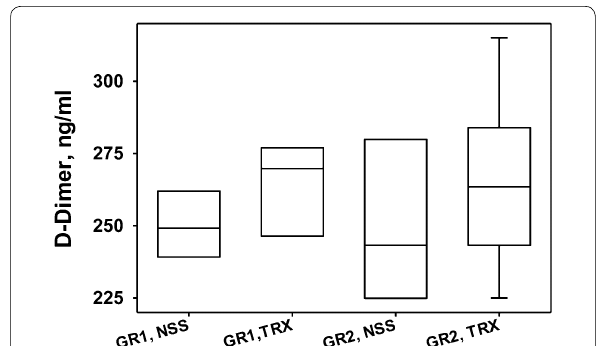
Fig. 8 The effect of fibrinolytic therapy on concentrations of d -dimers in BAL of Groups 1 and 2. The concentration of d -dimer in BAL of ISIALI sheep after fibrinolytic therapy was measured using a sheep d -dimer (D2D) ELISA Kit (MyBioSource, CA) as described in “Methods”. Sheep with induced smoke ALI was treated with nebulized scuPA (4 mg) or tPA (4 mg) (Gr1, TRX) and scuPA (4 mg or 8 mg) or tPA (4 mg) (GR2 TRX) or vehicle control (Gr1, NSS and Gr2, NSS). BAL (Gr1: 5 saline-controls, GR1 TRX: 11 scuPA and tPA treated animals; Gr2: 6 saline controls, 5 and 7 animals treated with 4 and 8 mg of nebulized scuPA respectively, and 5 animals treated with 4 mg nebulized tPA) was collected at 48 h after the initiation of ISIALI as described in Fig.